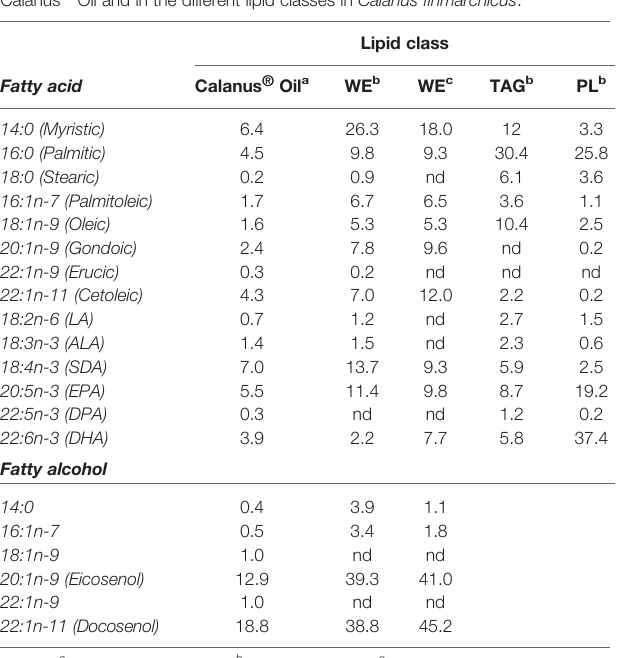
TABLE 2 | Fatty acid and fatty alcohol composition (mass %) of the commercial Calanus ® Oil and in the different lipid classes in Calanus fi nmarchicus . Lipid